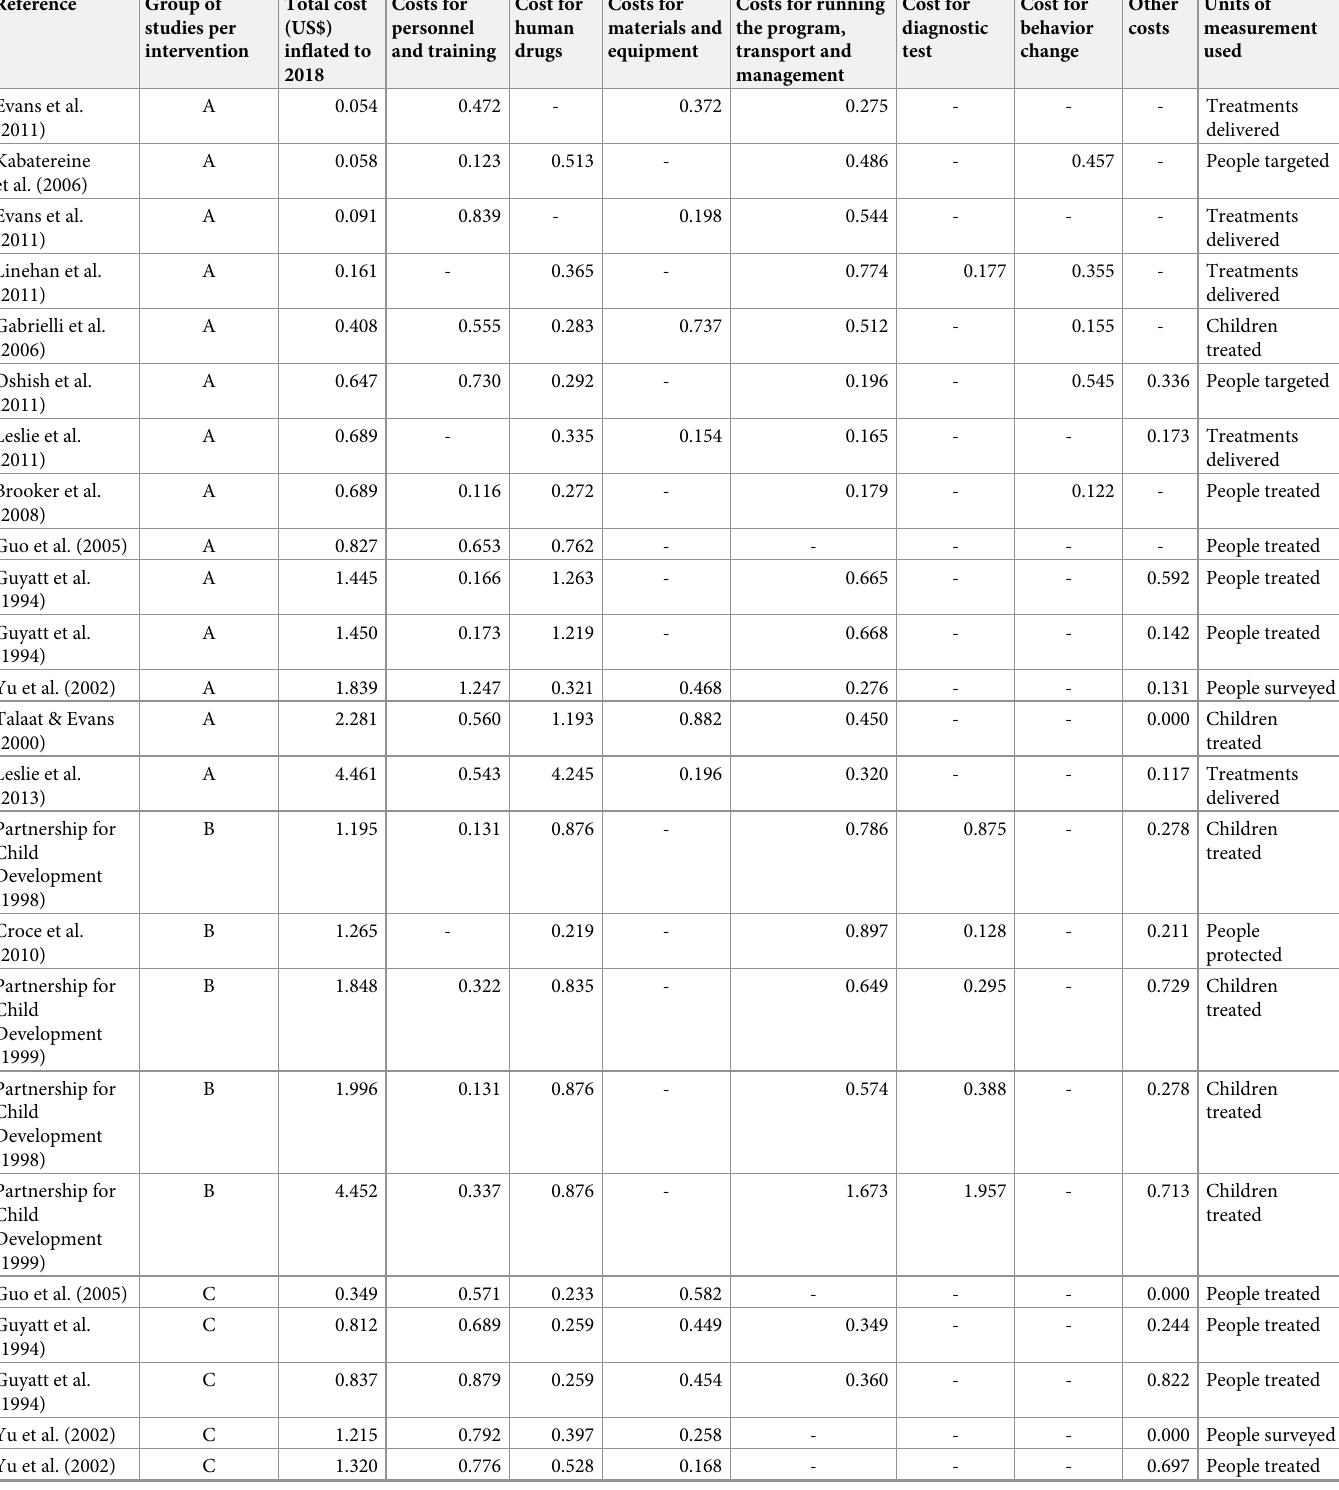
Table 3. List of analyses and their unit costs, ordered by groups of interventions.